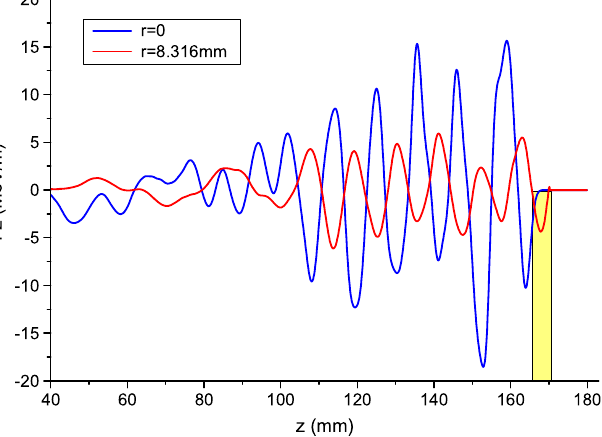
2. Axial force from wakefields set up by a single 50 nC, 14 MeV drive bunch in the CDWA structure described in Table